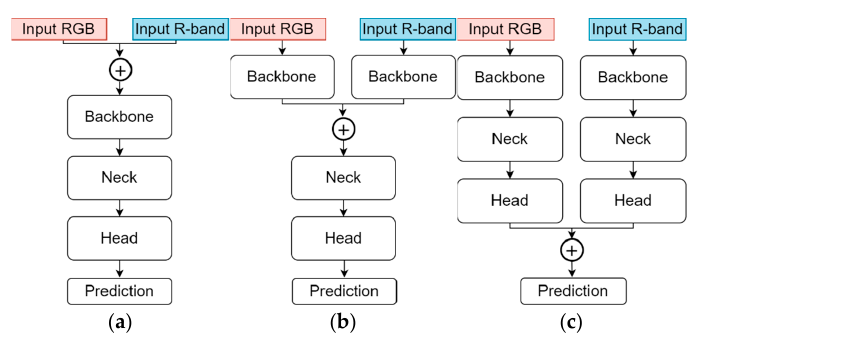
Figure 8. Network fusion modes: ( a ) Input Fusion, ( b ) Halfway Fusion, ( c ) Late Fusion.